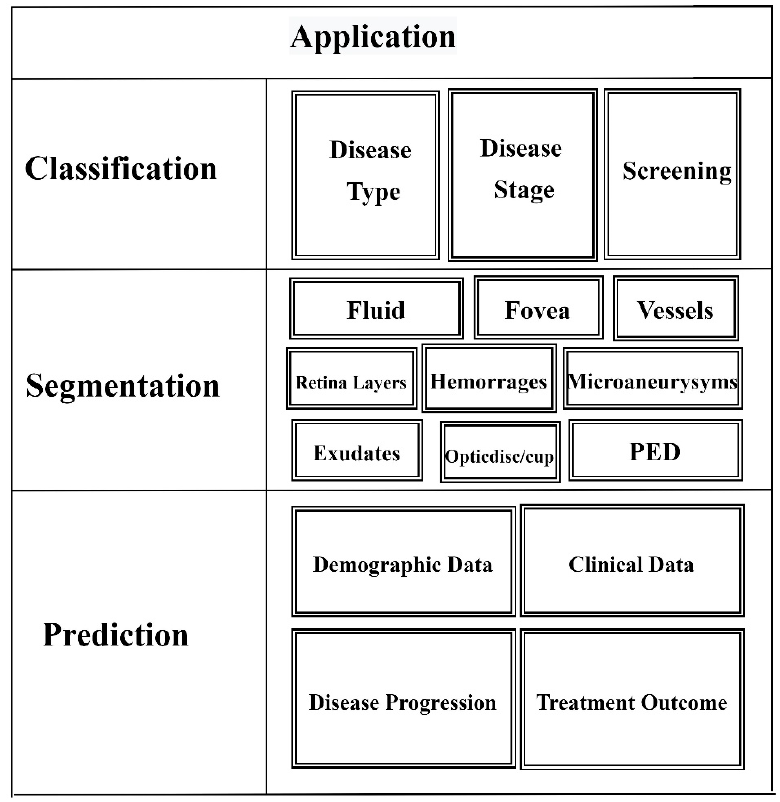
Figure 1. Applications of AI in retina imaging.